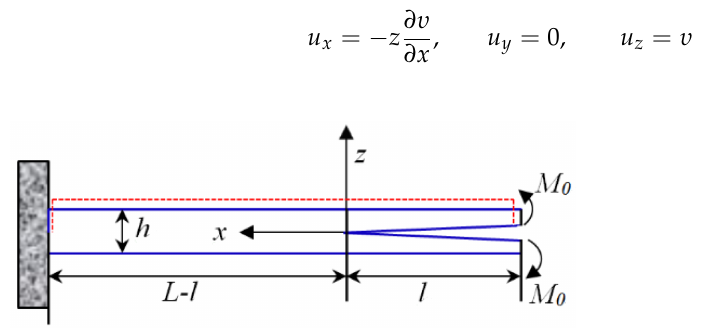
Figure 1. Schematic of a beam with